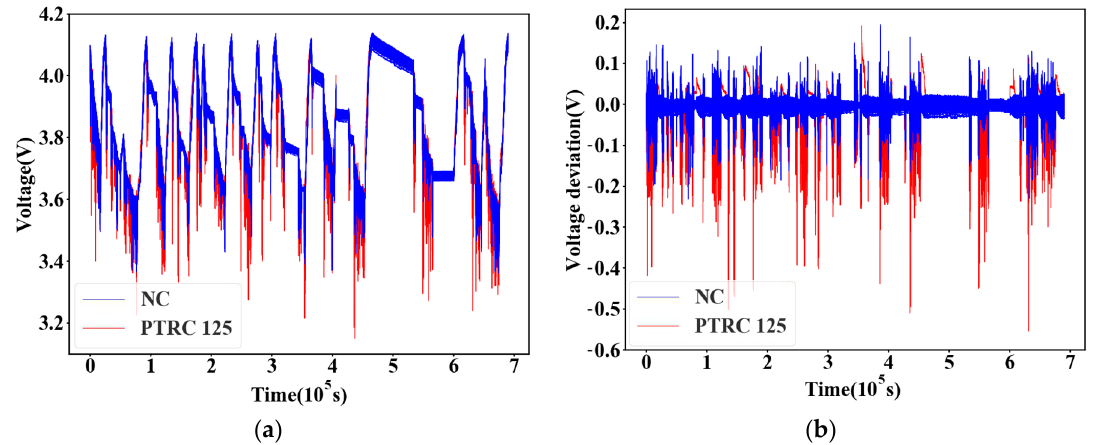
Figure 4. ( a ) The voltage curves of vehicle 1; ( b ) The voltage deviation curves of vehicle 1.